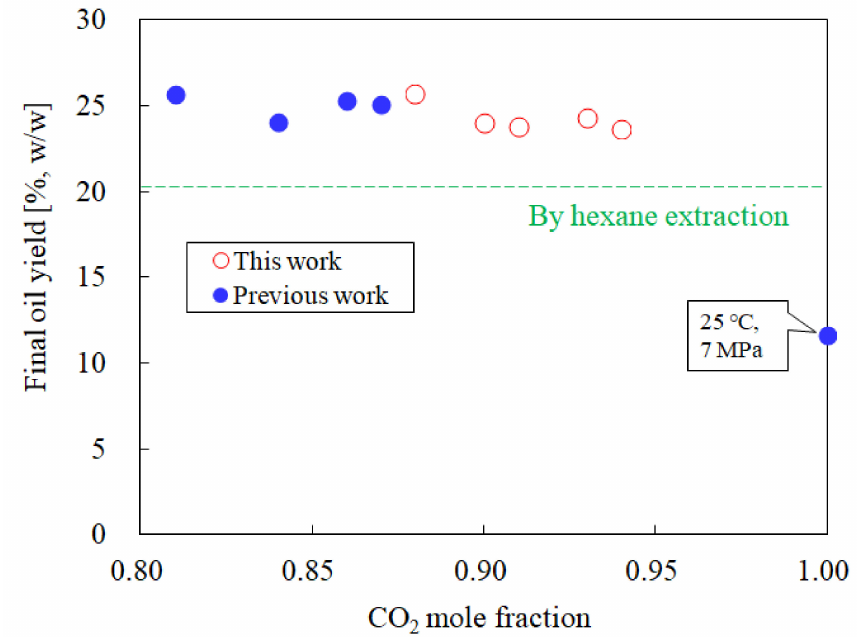
Figure 4. Relationship between the final oil yield and the CO 2 mole fraction by using CO 2 -expanded hexane at 25 ◦ C and 5.0–5.2 MPa, and comparison with the yields obtained by using liquid CO 2 at 25 ◦ C and 7 MPa, and hexane at 0.1 MPa. Previous work is shown in ref.